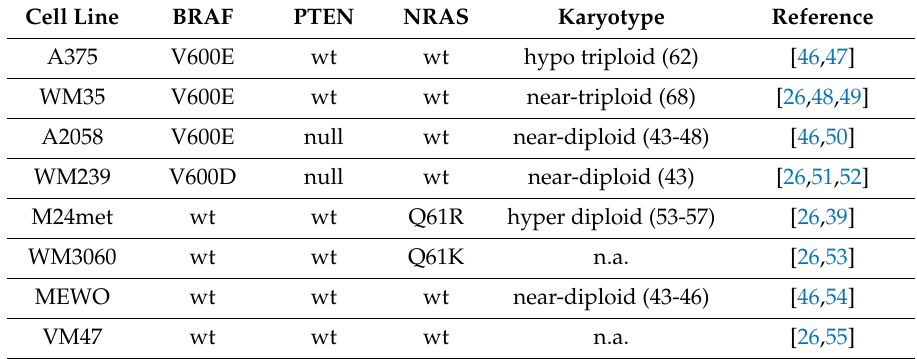
Table 1. Melanoma cell lines by NRAS, BRAF, and PTEN mutational status and karyotype. (n.a = not